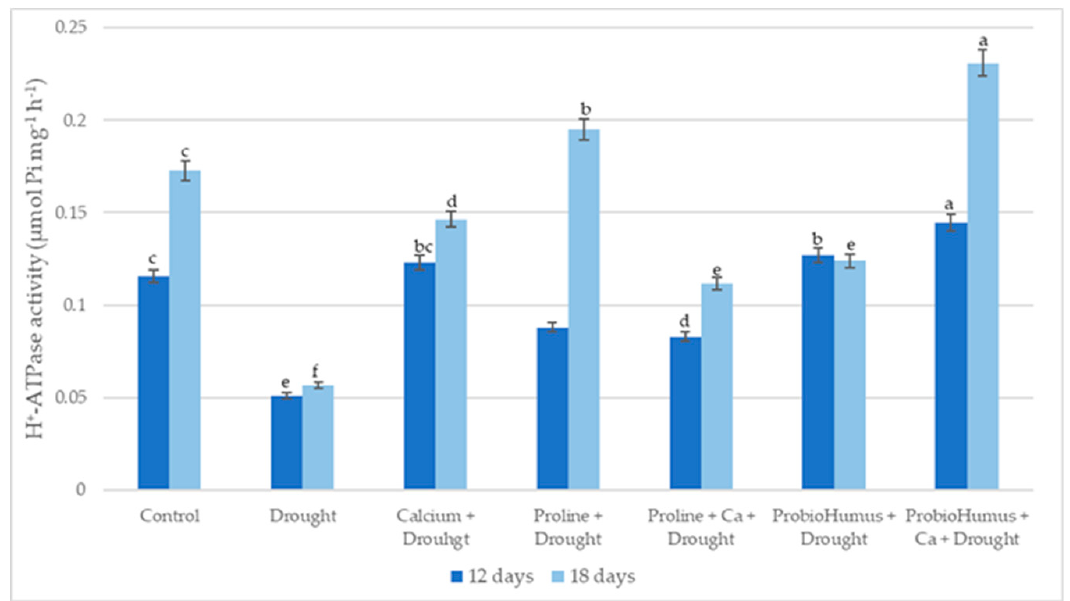
Figure 6. The effect of stress-protecting compounds application and prolonged drought stress (12 and 18 days) on winter wheat PM ATPase activity. Error bars represent the standard deviation of the mean. Control, Ca, proline, proline + Ca, ProbioHumus, and ProbioHumus + Ca indicates the type of application. Different lowercase letters in the same day of drought indicate statistically significant differences ( p <